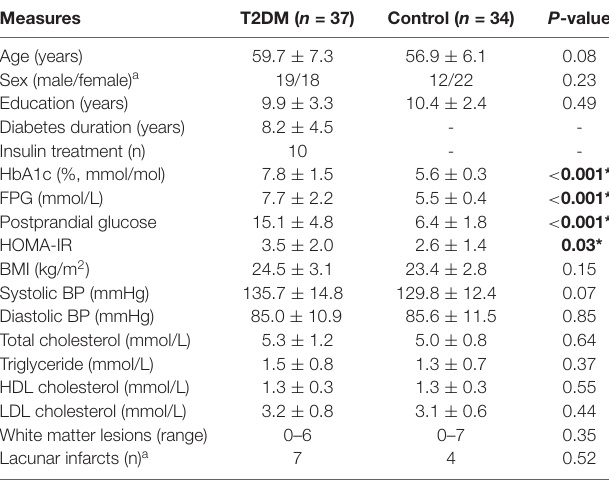
TABLE 1 | Demographics and clinical variables of the study